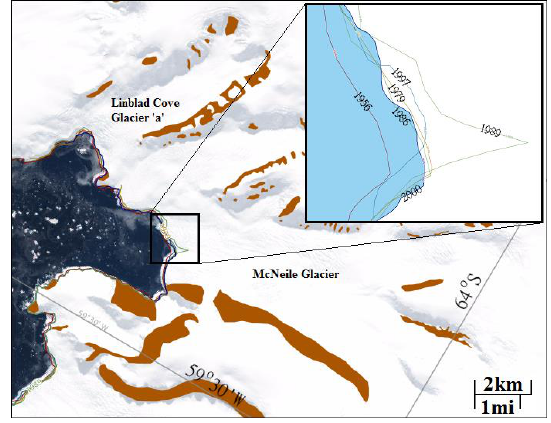
Figure 4. An example of variability in costal changes from 1956, 1979, 1986, 1989, 1997 and 2000 mapped from various data sources in The Antarctic Digital Database (BAS, 2015). Background image is LIMA mosaic. Geographic Coordinate